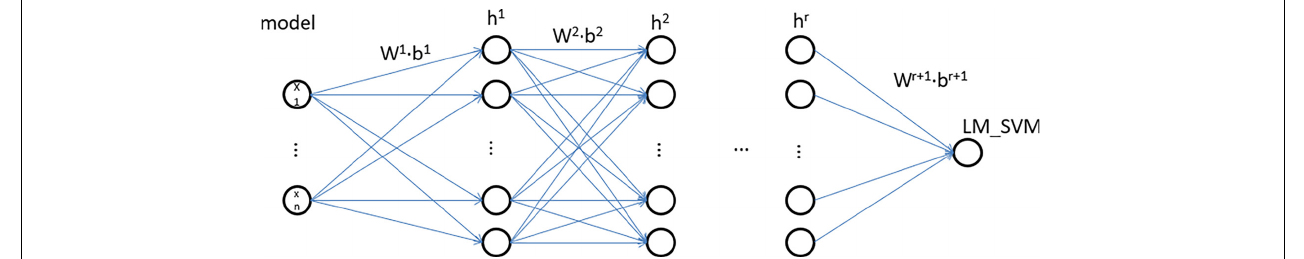
FIGURE 4 | IDNN structure.